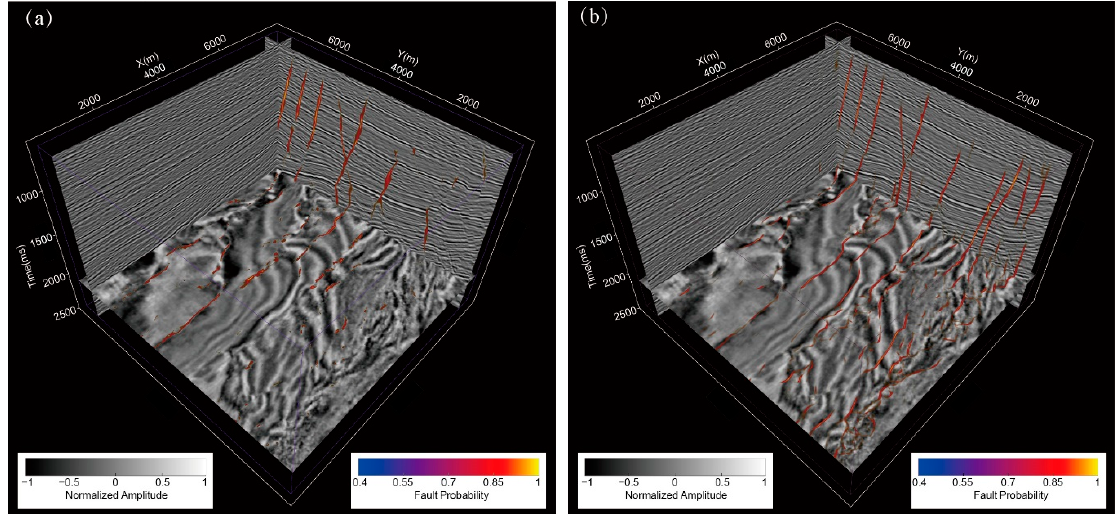
Figure 9. The second 3D seismic data are displayed with faults probabilities that are predicted by using ( a ) the pre-trained U-Net model and ( b ) the U-Net model after transfer learning.